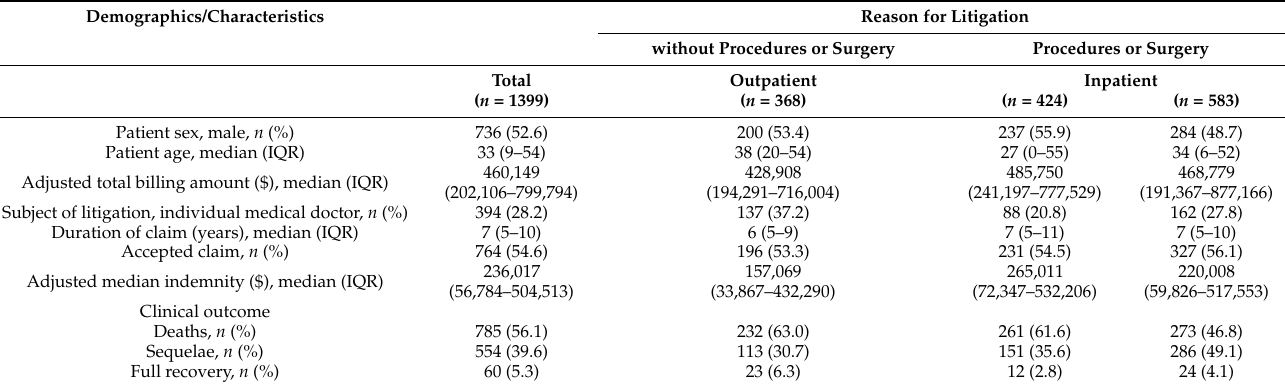
Table 1. Patient demographics and characteristics of litigation against medical doctors in Japan ( n = 1399).